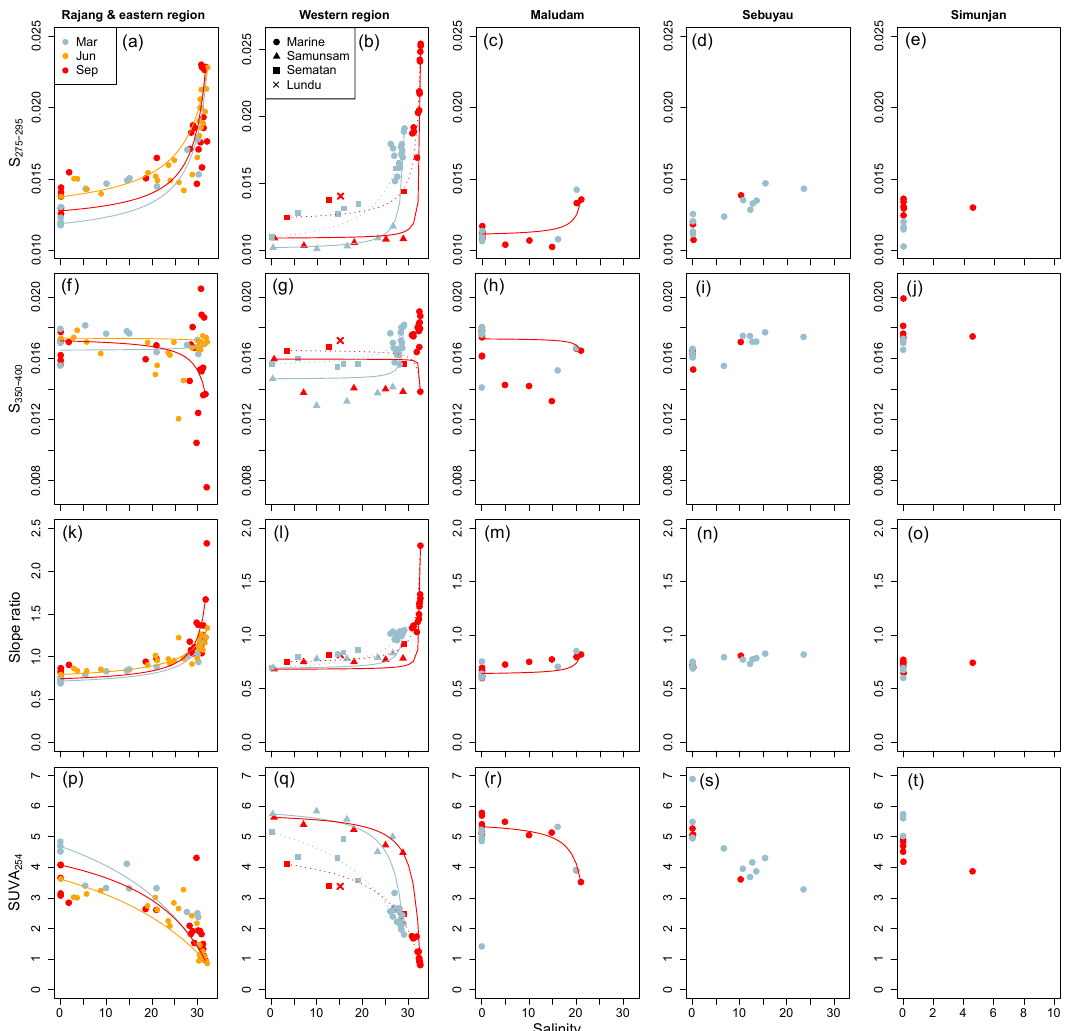
Figure 4. Changes in (a–e) S 275–295 , (f–j) S 350 − 400 , (k–o) CDOM spectral slope ratio, and (p–t) SUVA 254 from rivers to coastal seawater. Conservative mixing lines are shown as in Fig. 2 (note that conservative mixing of CDOM properties is non-linear). Data are shown separately for each sampling region as indicated by column